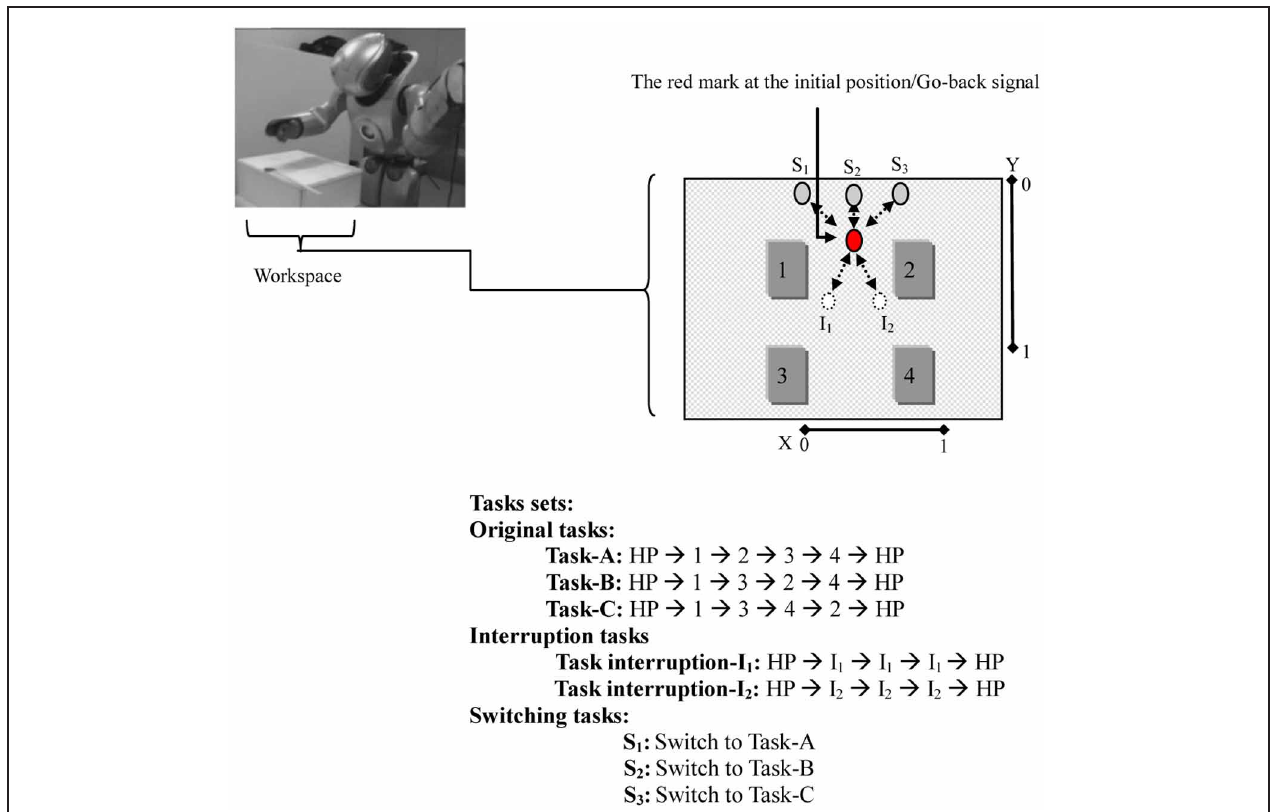
the red mark to one of these positions stimulates the robot to execute the corresponding task. The dotted arrows indicate the paths of the red mark. In the tasks sets: home-position (HP)refers tothe robot’s arminitsinitialposition. In one Task-A set, for instance, the robot starting its arm from HP, moves to dial 1 → 2 → 3 → 4, and then ends the task by returning its arm to